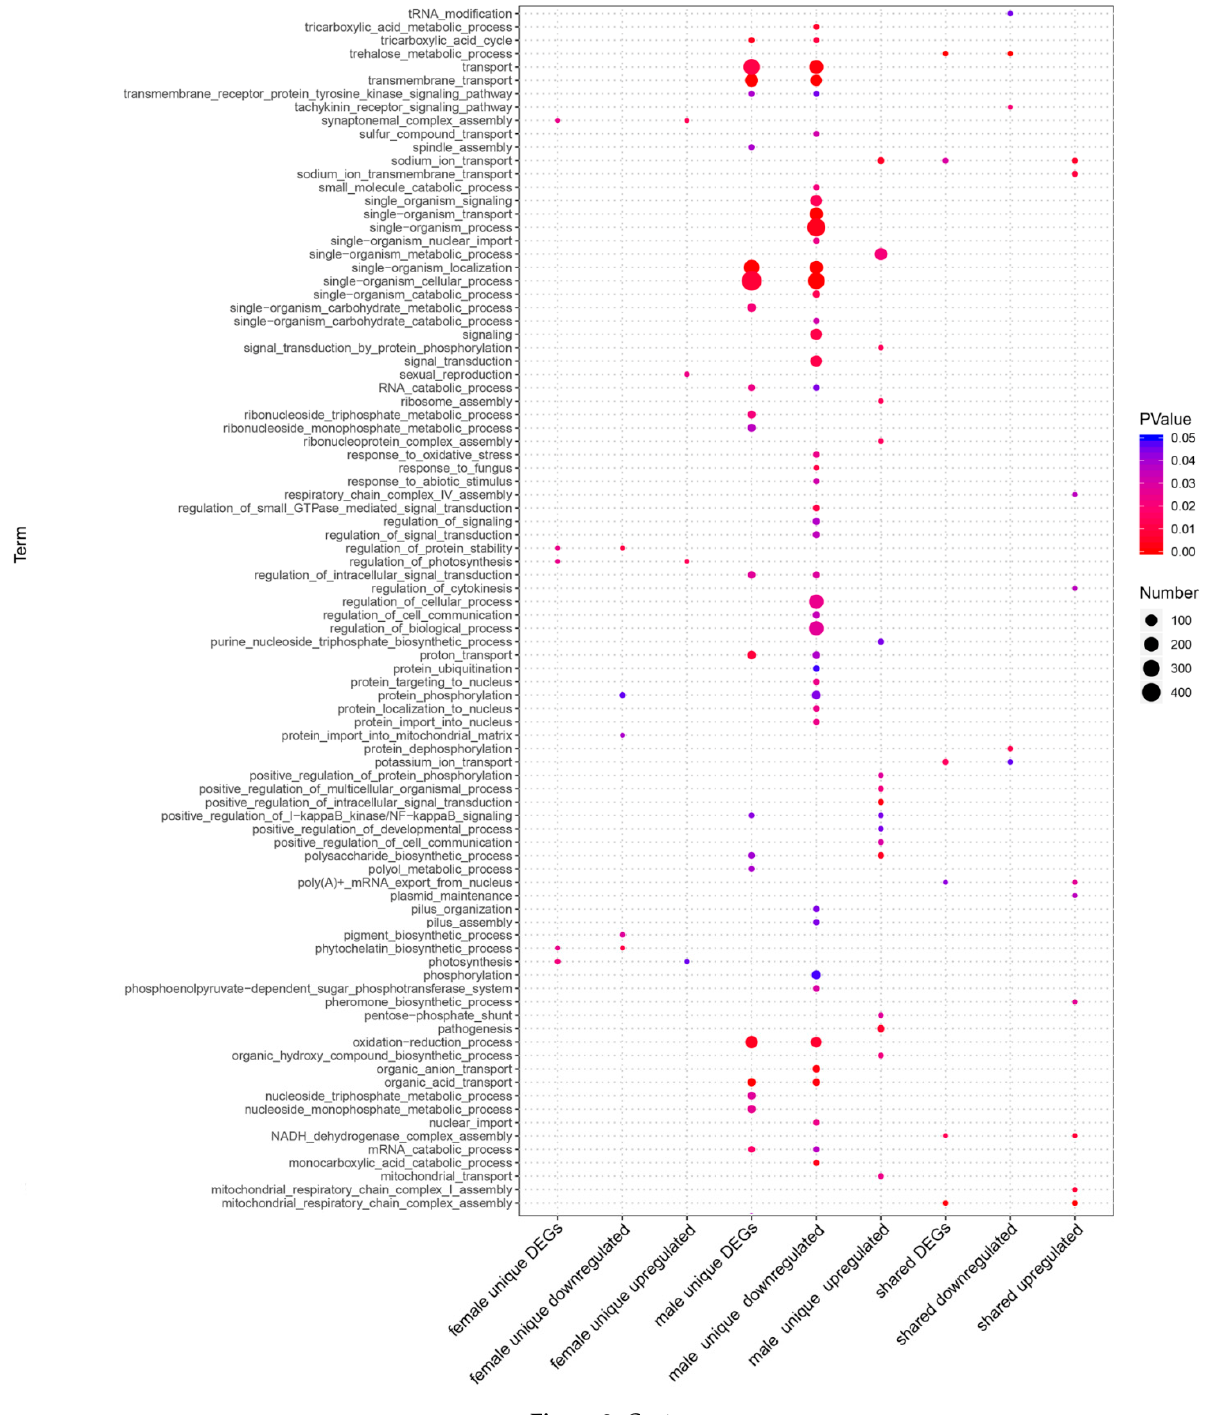
Figure 2. Cont Figure 2. Biological processes of GO enrichment analysis for the “ Wolbachia -infection associated DEGs”. The results show that males have the most significantly enriched GO items for the DEGs ( p value < 0.05).